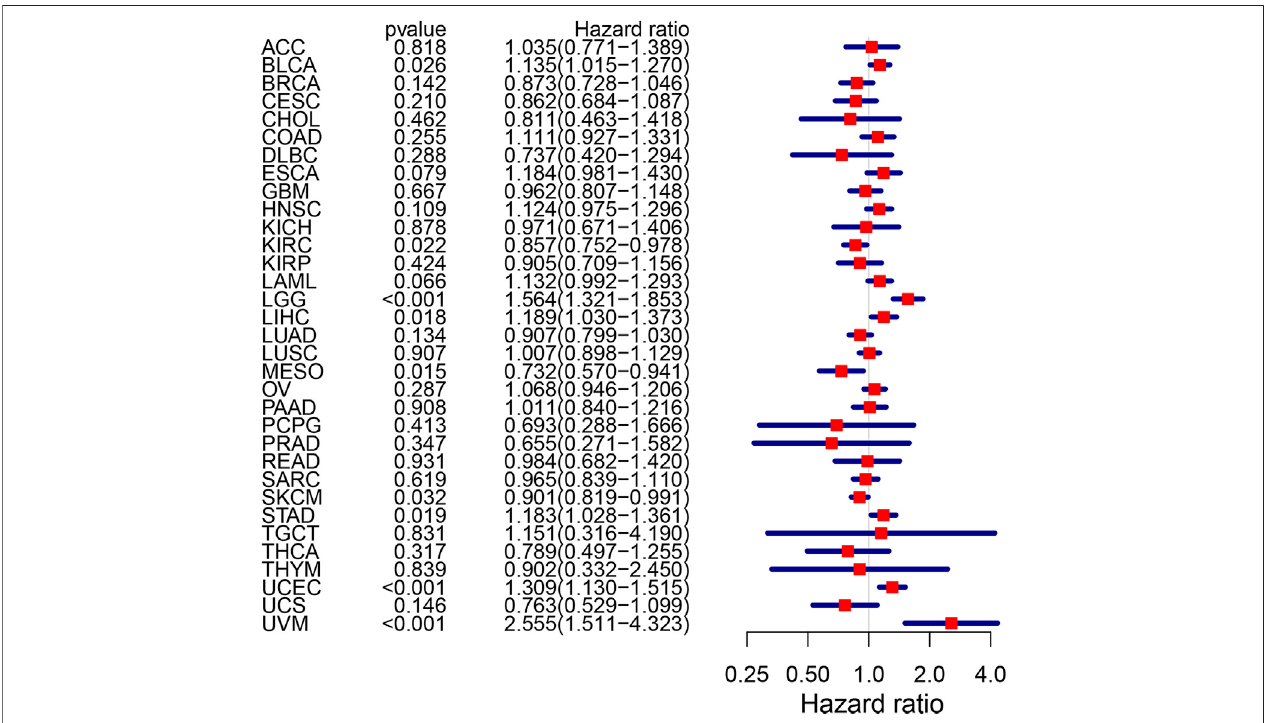
FIGURE 8 | The risk rate of CPVL gene in pan-cancer. CPVL is associated with patients ’ survival in BLCA, KIRC, LCC, LIHC, MESO, SKCM, STAD, UCEC, and UVM ( p < 0.05). The hazard ratio greater than 1 indicates a high-risk gene(s), meaning that patients with high expression of such gene(s) have a worse prognosis; the hazard ratio less than 1 indicates a low-risk gene(s) for particular cancer, meaning that patients with high expression have a better prognosis.